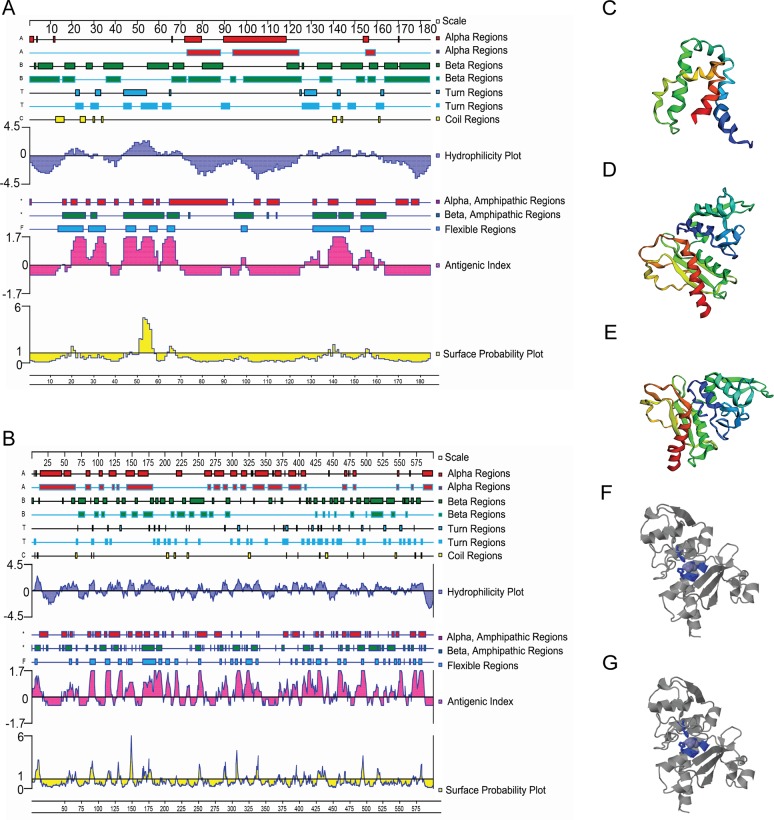
Secondary and tertiary structures and potential binding sites of the recombinant proteins.(A) Amastin Secondary structure containing surface properties. (B) Gp63 Secondary structure containing surface properties. (C) Duplex protein Amastin-Kmp-11 tertiary structures. Image is coloured by rainbow N → C terminus. Model dimensions Model dimensions (Å): X:56.047 Y:34.951 Z:66.482. A total of 85% of the residues were modelled with 98.4% confidence. (D) Duplex protein Amastin-Gp63 tertiary structures. Image is coloured by rainbow N → C terminus. Model dimensions Model dimensions (Å): X:46.104 Y:49.312 Z:55.074. A total of 72% of the residues were modelled with 100% confidence. (E) Duplex protein Kmp-11-Gp63 tertiary structures. Image is coloured by rainbow N → C terminus. Model dimensions Model dimensions (Å): X:46.104 Y:49.312 Z:55.074. A total of 65% of the residues were modelled with 100% confidence. (F) Potential binding sites of duplex protein Amastin-Gp63. Four potential binding sites 200HIS, 201GLU, 204HIS and 270HIS were predicted and coloured by blue. (G) Potential binding sites of duplex protein Kmp-11-Gp63. Four potential binding sites 221HIS, 222GLU, 225HIS and 291HIS were predicted coloured by blue.